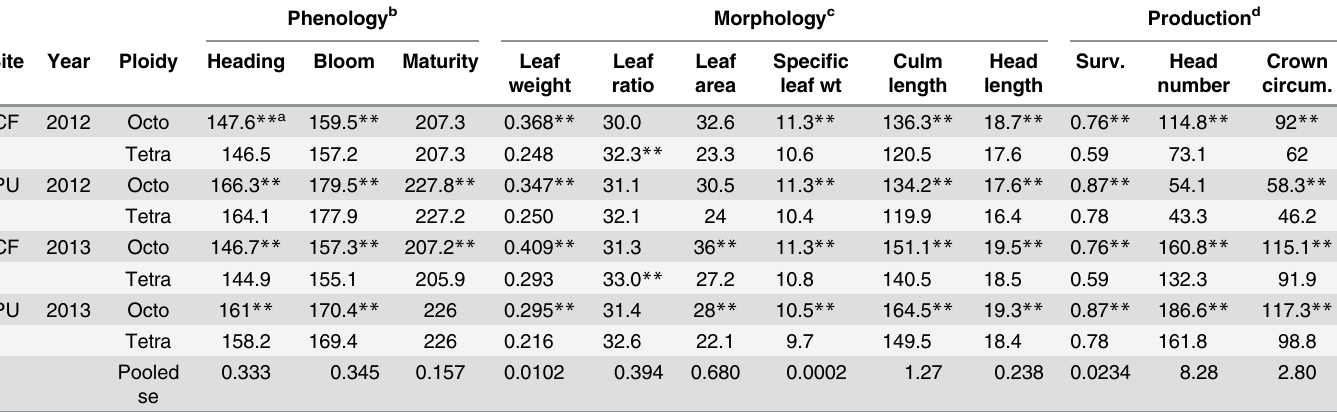
Table 3. Mean comparisons between wild octoploid (n = 57) and tetraploid (n = 52) basin wildrye among years and common gardens sites at Cen- tral Ferry (CF) and Pullman (PU),